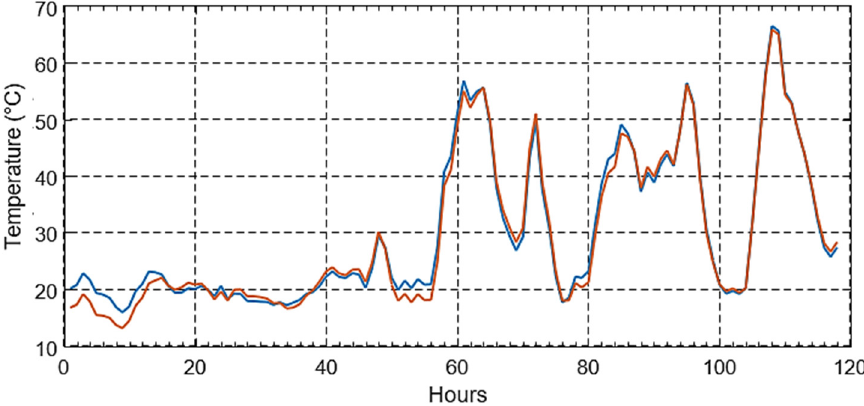
Figure 42. Oil temperature at the top of the oil through simulated (blue) and measured (orange) ambient temperature for January.